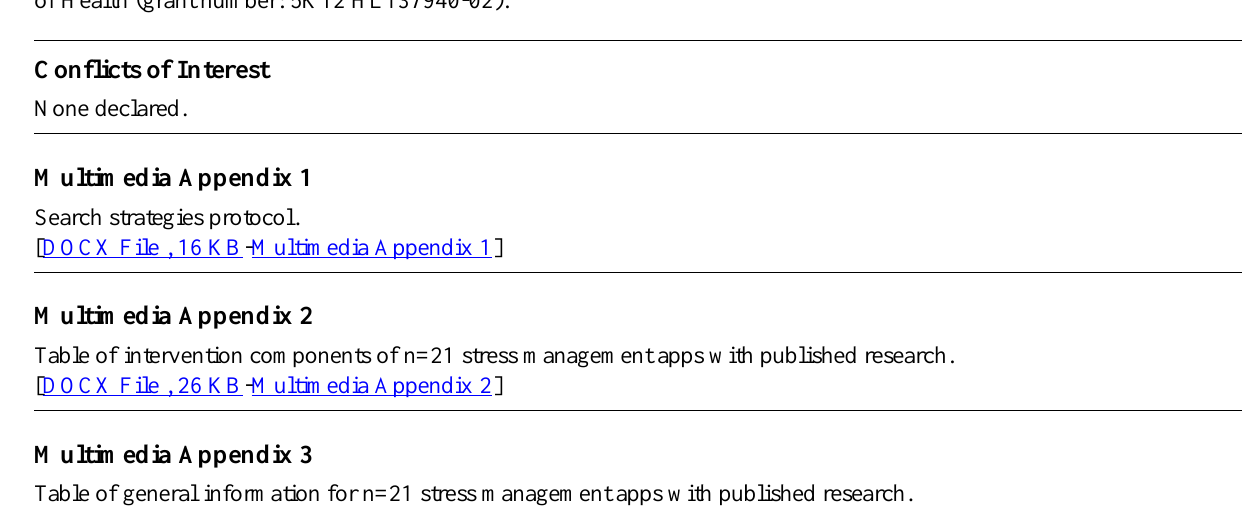
Table of general information for n=21 stress management apps with published